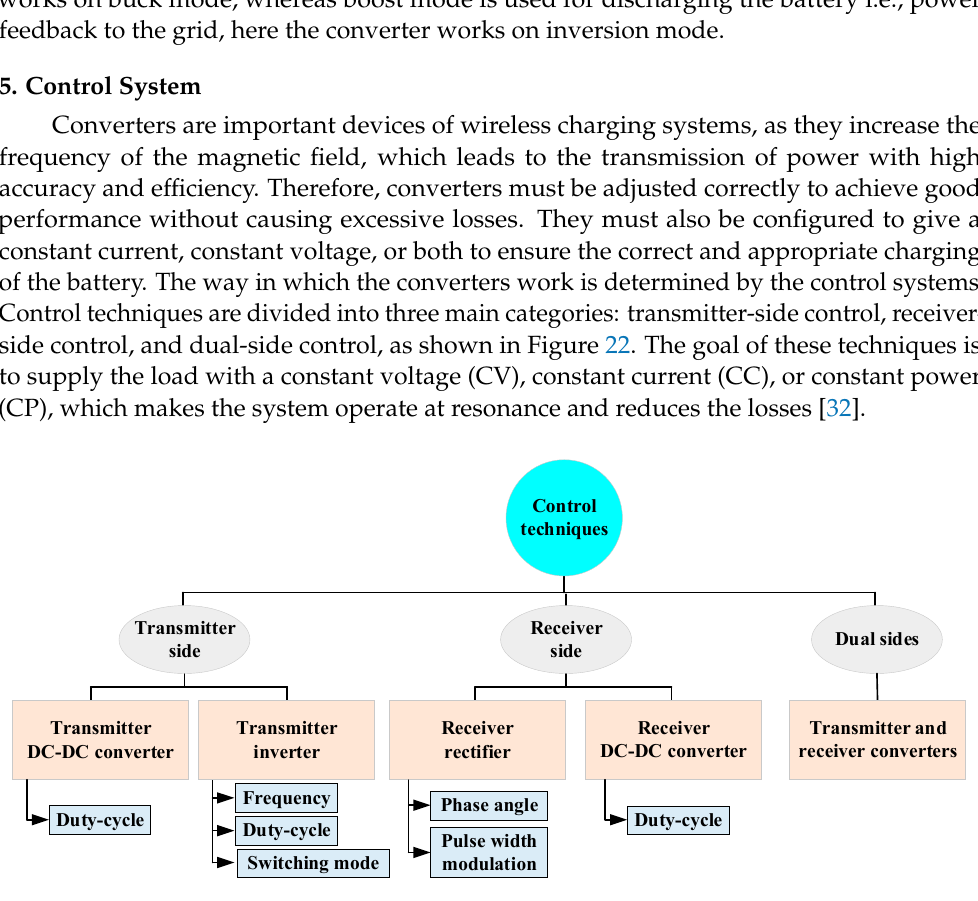
Figure 22. Various control techniques for a wireless power transfer system.